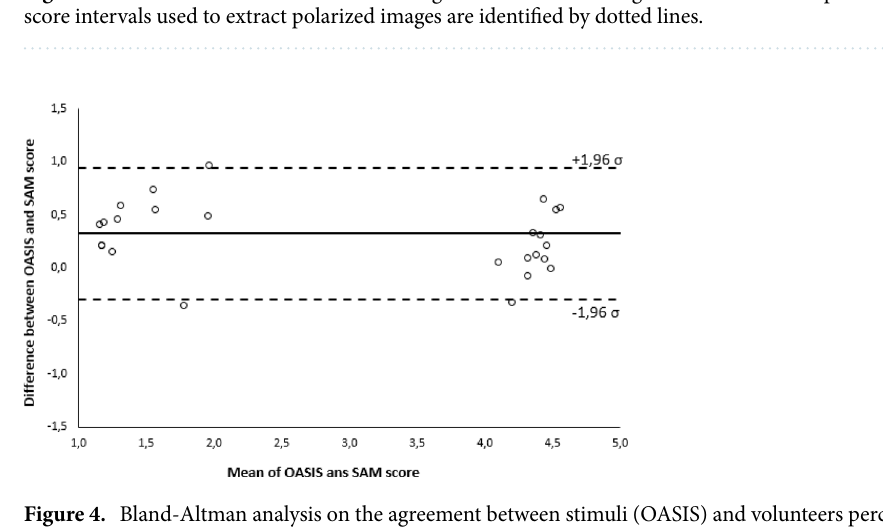
Figure 4. Bland-Altman analysis on the agreement between stimuli (OASIS) and volunteers perception (SAM).